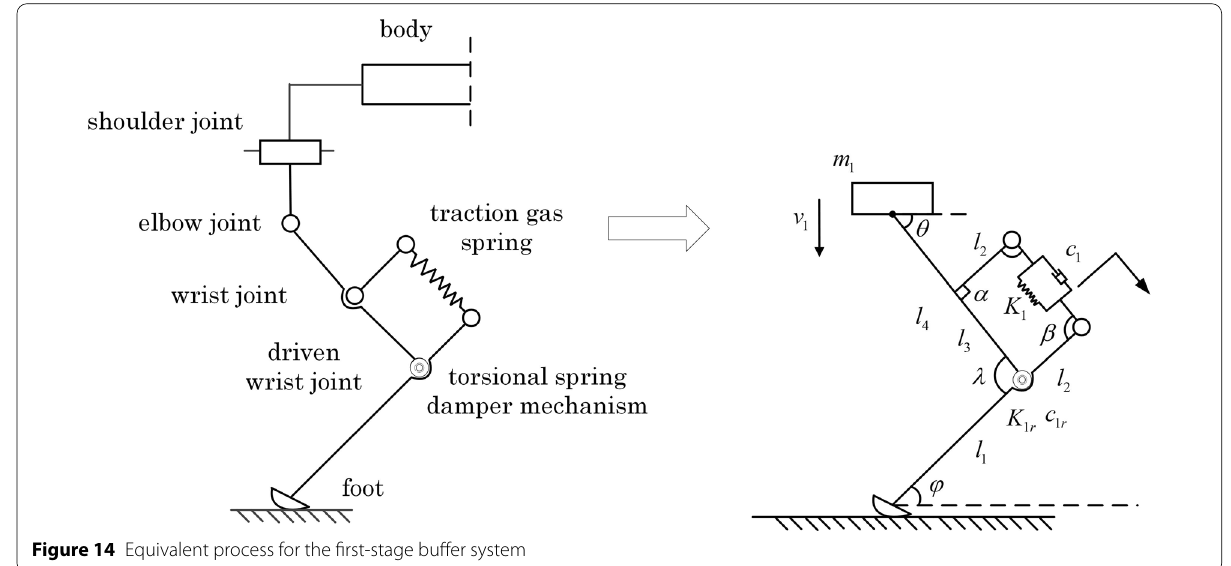
Figure 14 Equivalent process for the first-stage buffer system